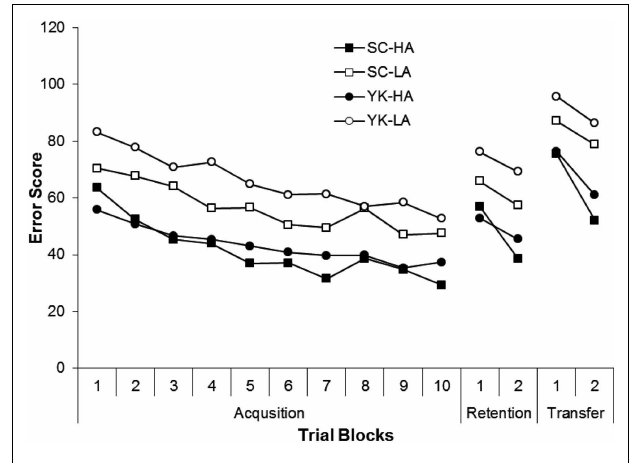
FIGURE 1 | Mean error scores for the Self-Control-HighActivity (SC-HA),Yoked-HighActivity (YK-HA), Self-Control-LowActivity (SC-LA), andYoked-LowActivity (YK-LA) groups during each trial block of acquisition, retention, and transfer. A lower score represents more accurate performance.